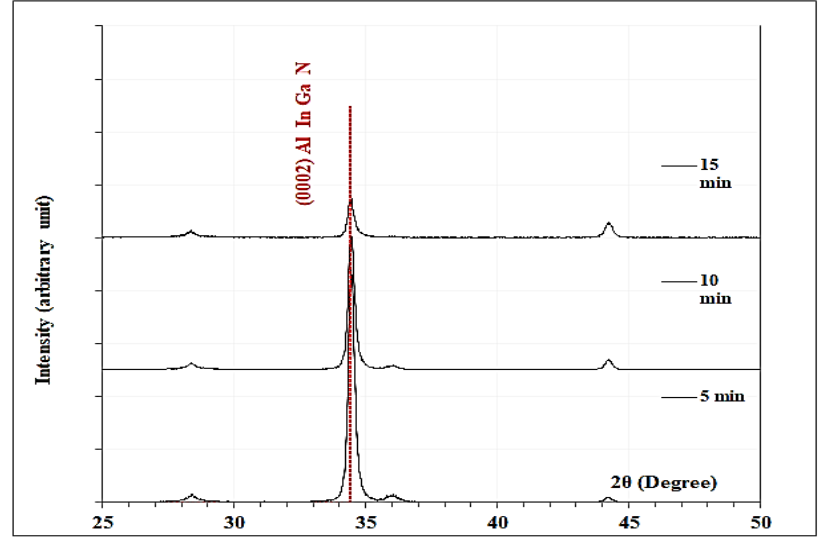
Figure 3: XRD spectrum of (0002) porous quaternary Al